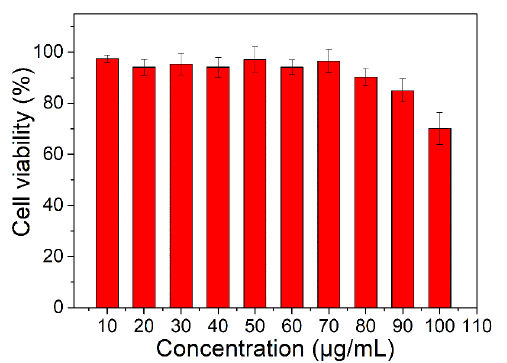
Fig. 5. Cell viability of Bcap 37 cells after incubation with PDTSDTBT nanoparticles. solutions in various concentration. The error bars represent the standard deviations of three sep- arate measurements.